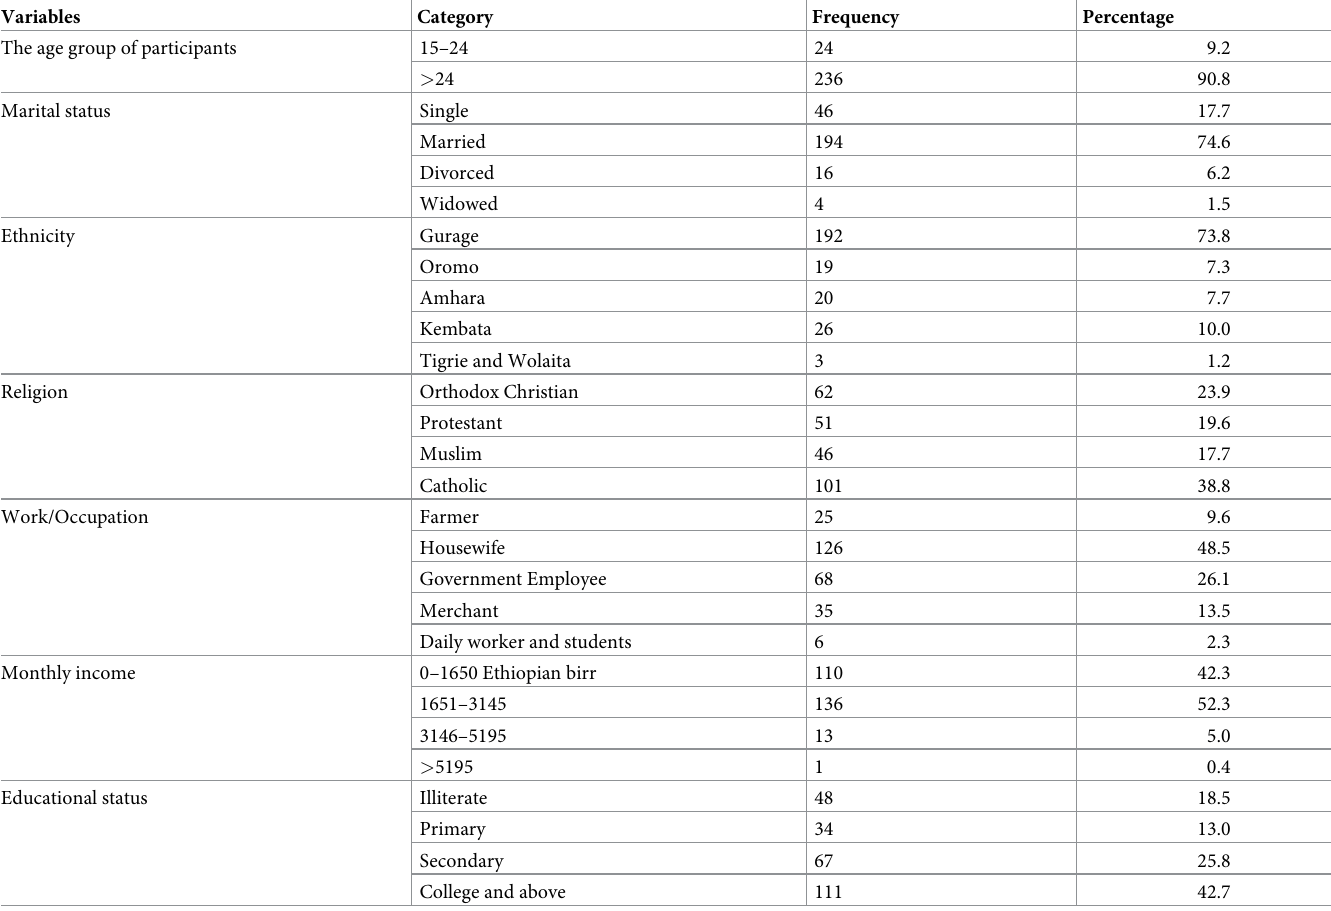
Table 1. Socio-demographic characteristics of respondents among reproductive age group women in districts of Gurage zone, Southern Ethiopia,